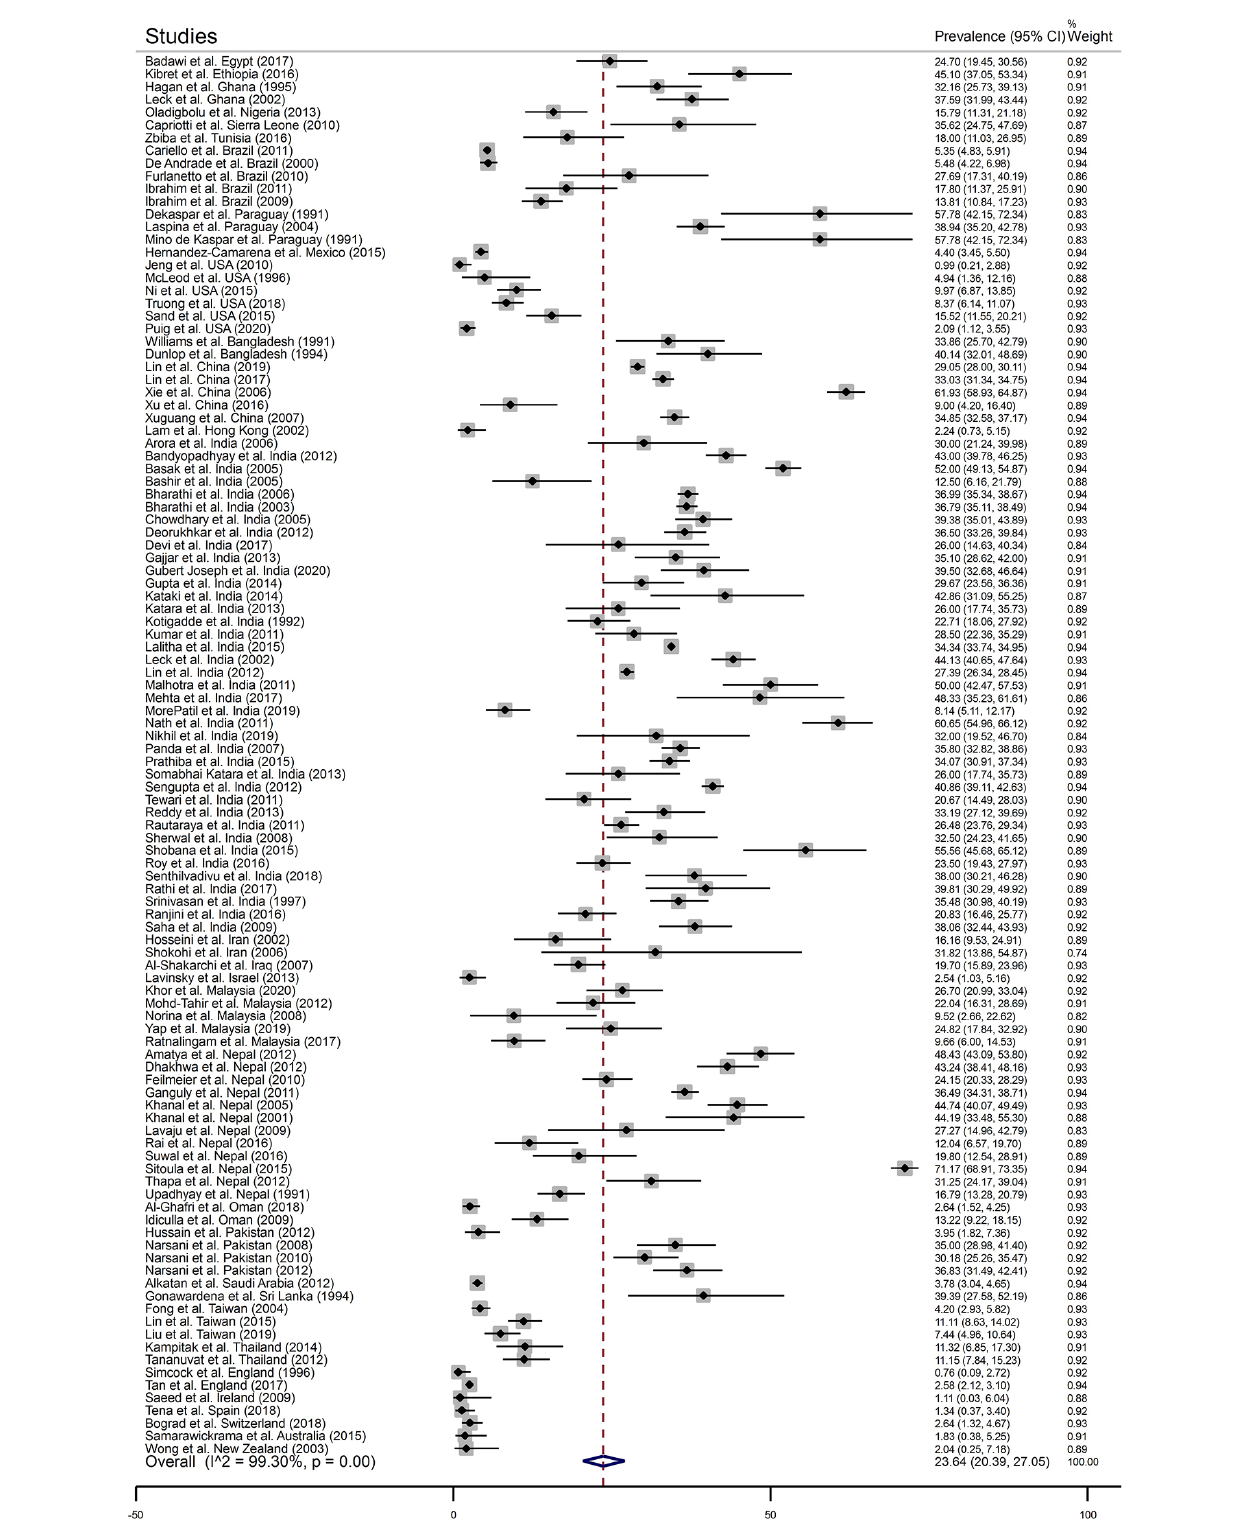
FIGURE 2 | The forest plot of the prevalence of fungal keratitis among patients with a clinical suspicion of microbial keratitis based on the reported articles between January 1, 1990 and May 27, 2020.